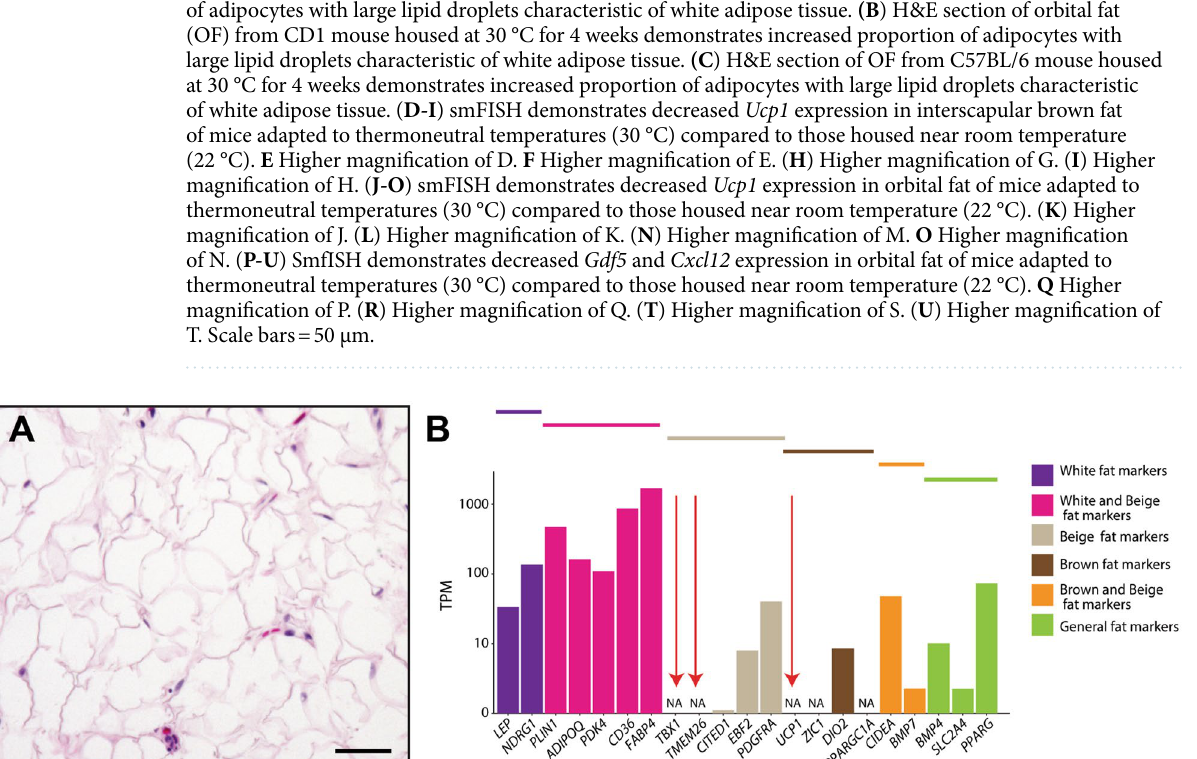
Figure 5. Human orbital adipose tissue is histologically similar to white fat, but expresses white, beige, and brown fat markers. ( A ) H&E stained section of human orbital fat reveals cells with large lipid vacuoles. Scale bar = 50 μm. ( B ) Comparison of transcriptome data from human orbital fat to publicly available data from various human was performed in triplicate using on a … using the following primer sets: PPIA (CAG ACG CCA CTG TCG CTT T, TGT CTT TGG AAC TTT GTC TGCAA), Ucp1 (AGG CTT CCA GTA CCA TTA GGT, CTG AGT GAG GCA AAG CTG ATTT), Cidea (TGA CAT TCA TGG GAT TGC AGAC, GGC CAG TTG TGA TGA CTA AGAC), Gdf5 (CCC ATC ACA CCC CAC GAA TA, CTC GGT CAT CTT GCC CTT TG). PPIA was chosen as a reference gene after com- One-way ordinary ANOVA of data was performed using Prism (GraphPad).